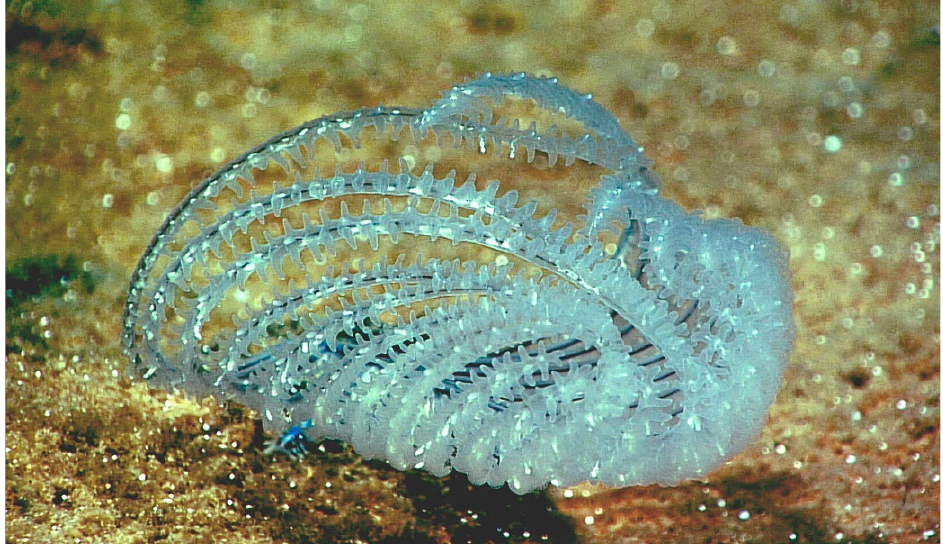
Figure 1. Abyssopathes lyra (Brook, 1889). In situ photo of specimen USNM 1453760 with a character- istic basket-like corallum. Photo courtesy of the NOAA OER (Note: color enhanced to show details).